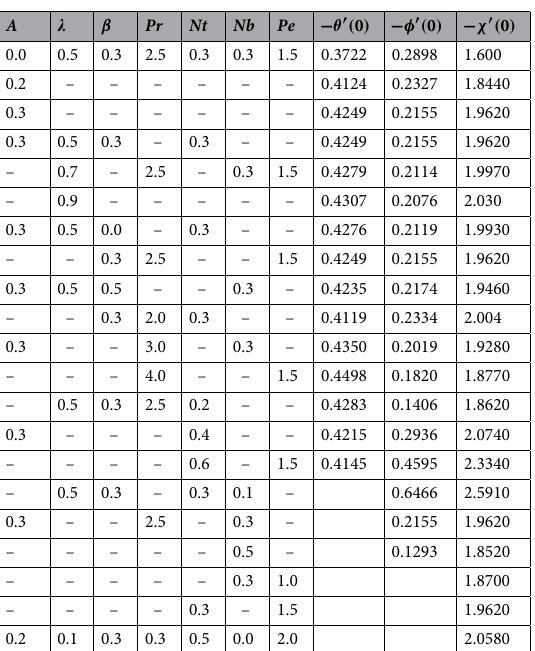
0.5 0.5 , Sh x ( Re x ) − , and Qn x ( Re x ) −